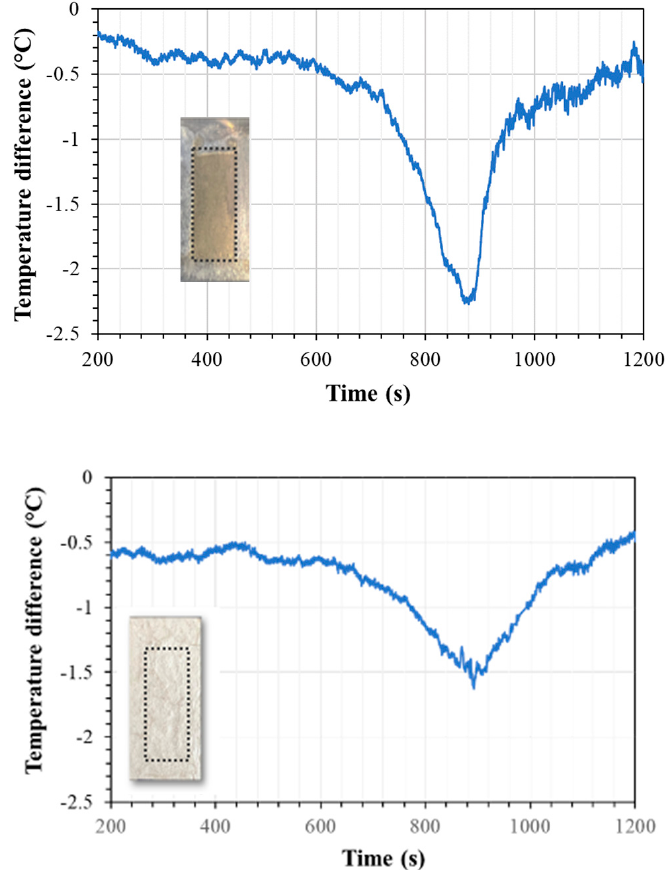
Figure 10. Surface temperature differences detected by a IR thermal camera between anodized samples with and without PCM that were sealed with epoxy resin ( top ) and silver paint ( bottom ). The images attached to the graphs show the areas where the anodic layer is located (dotted line). The epoxy coat is transparent, while the silver completely masks the location of the underlying composite structure.